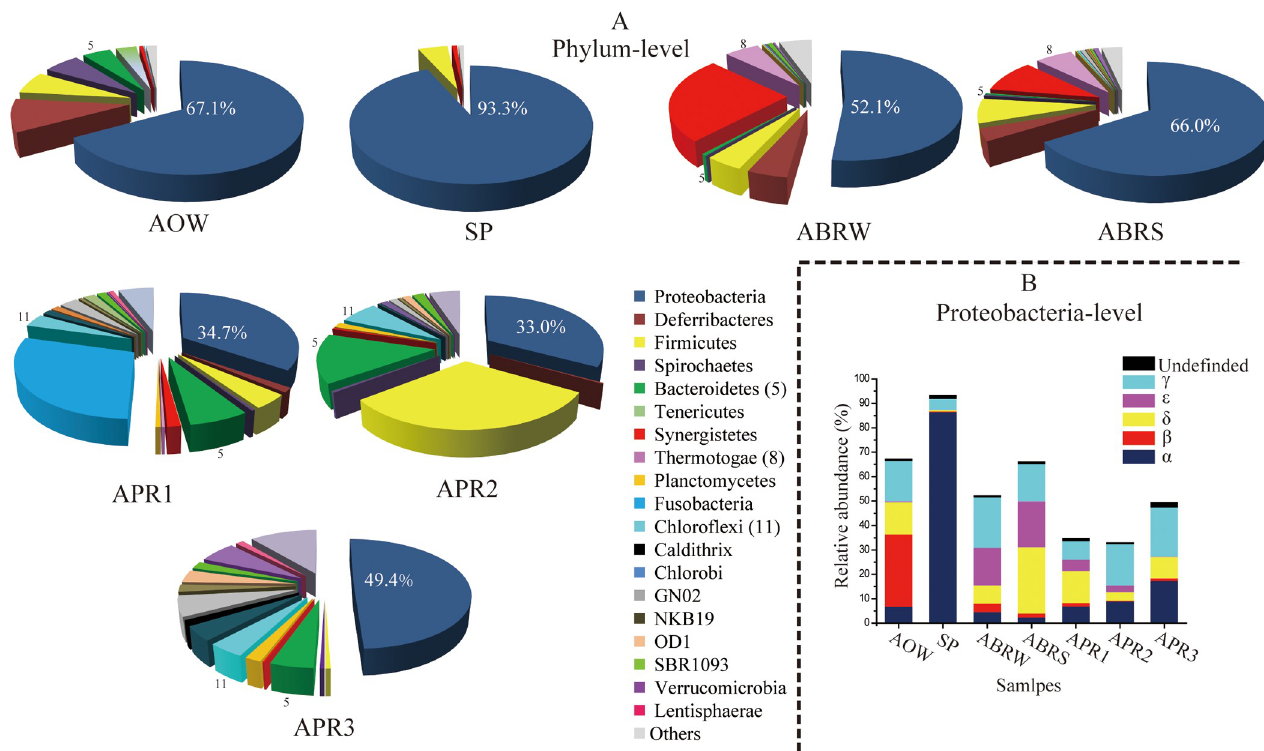
Fig 2. Pie charts showing the dominant distributions of the detected microbes at the level of phylum in the collected samples; histograms showing the dominant distributions of detected proteobateria-affiliated microbes at the level of class in the collected samples.